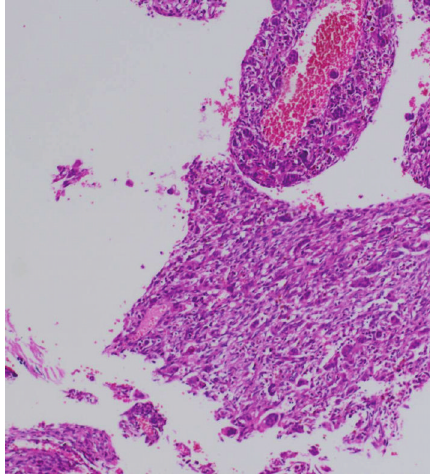
Figure 3: The giant cell form of malignant fibrous histiocytoma contains less mature bone in the tumor (H and E × 200).